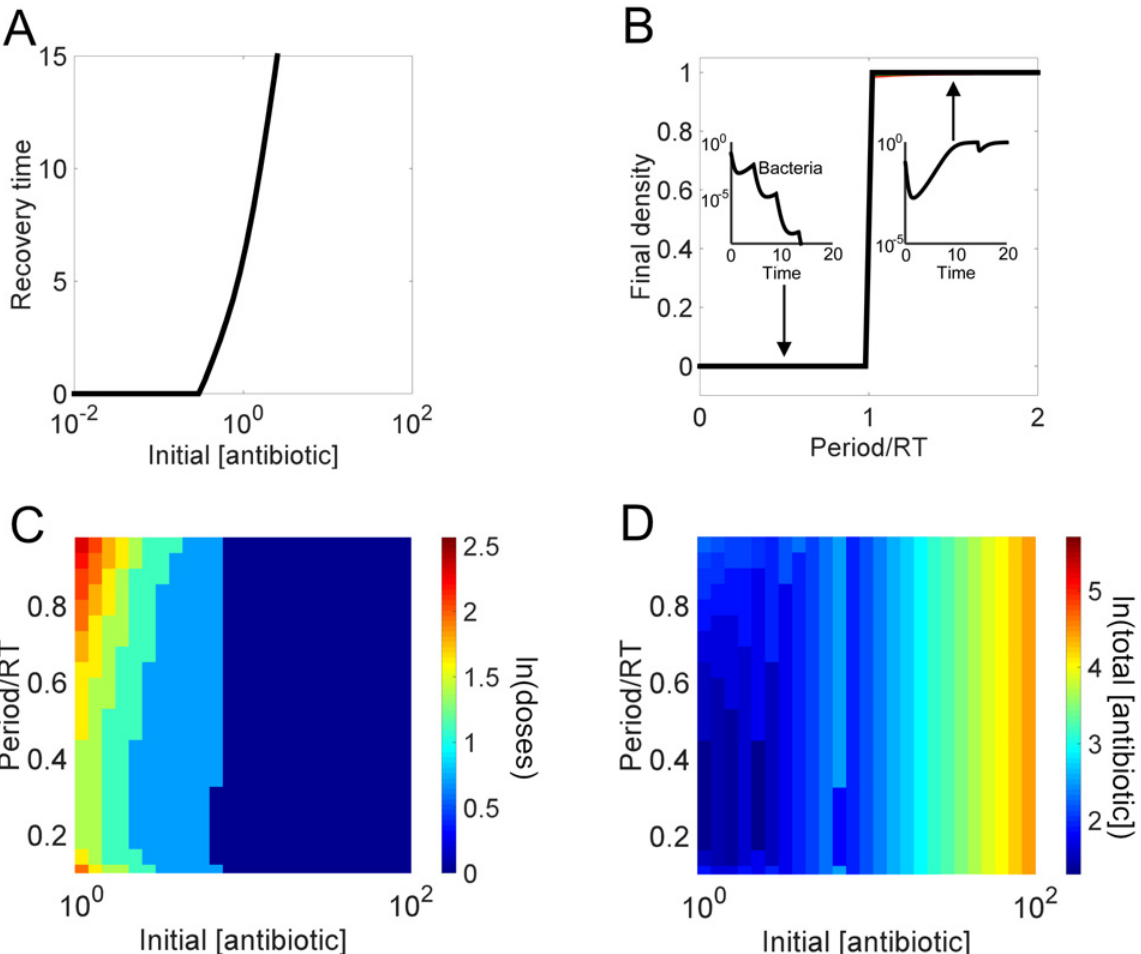
Fig 3. Recovery time guides design of effective injection based regimen. (A) Dependence of the recovery time on the initial antibiotic concentration . If the initial antibiotic concentration is too low, then the population will not be affected and its recovery time will be zero. However, after the initial antibiotic concentration is high enough, increasing the concentration results in an increase in the time it takes for a population to recover from a single dose. (B) Predictive power of recovery time for the outcome of long-term periodic antibiotic dosing . For each antibiotic concentration-period combination, we calculate the final population density after 100 antibiotic doses. Subplots demonstrate the outcomes for the first couple of doses of regimens using periods less than one recovery time (bacteria final density is below the defined threshold of 10 -10 ) versus regimens using periods greater than one recovery time (bacteria final density returns to carrying capacity). (C) Dependence of treatment efficiency on the antibiotic concentration and the dosing period . Each combination using an antibiotic concentration with a recovery time > 0 ( a 0 > 0.5) and any period less than 1 recovery time can eventually eliminate the population. Different combinations will reduce the population density to a pre-defined threshold (10 -10 ) with varying efficiency: the combination is more efficient if fewer doses are needed to reach the threshold. a 0 < 0.5 could not clear the infection in 100 doses. (D) Dependence of total antibiotic usage on the antibiotic concentration and dosing period . The total usage is calculated as the antibiotic concentration multiplied by number of doses needed to reduce population density to a predefined threshold.